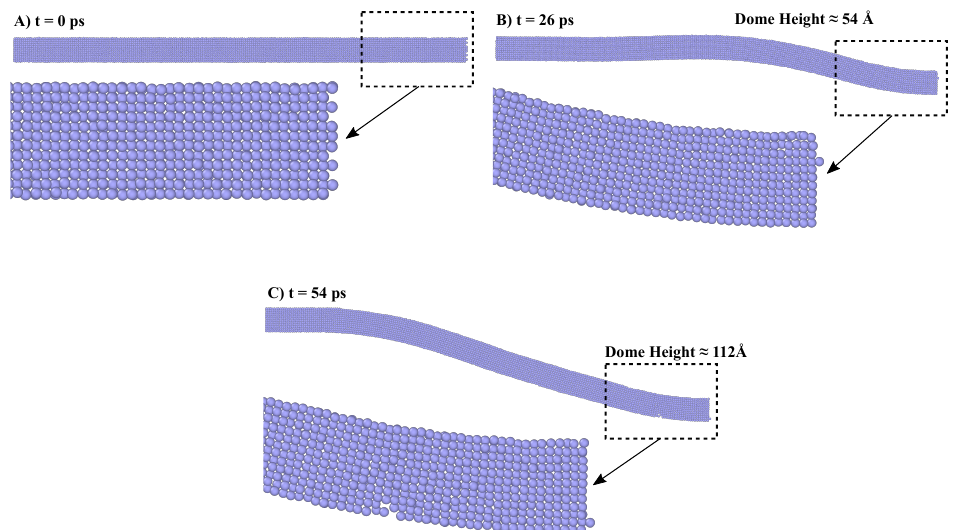
Figure 5. Different stages of loading at 2Å/ps. ( A ) denotes the initial condition with detailed view, that is, at Time = 0 ps. ( B ) denotes the intermediate position with detailed view of the workpiece at Time = 26 ps, where the dome-height at this time is approximately 54 Å. And ( C ) denotes the position of workpiece just before the failure with detailed view, that is, the position of maximum dome-height of approximately 112 Å.